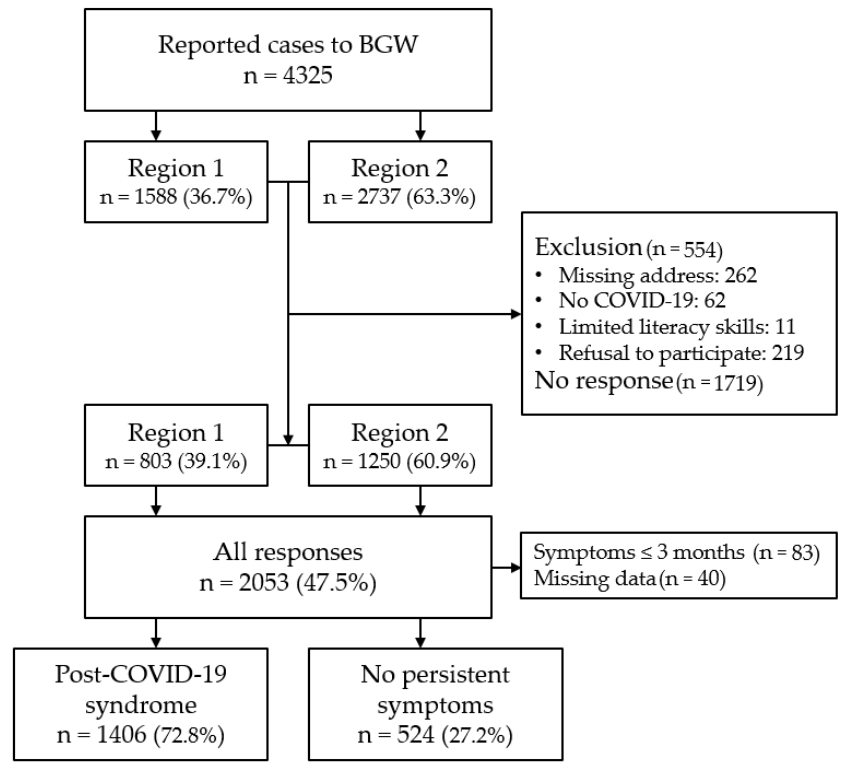
Figure 1. This flowchart describes the inclusion process of the study population and the categorisation into participants with persisting symptoms longer than 3 months (Post-COVID-19 syndrome) and without symptoms. BGW—Institution for Statutory Accident Insurance and Prevention in the Health and Welfare Services.